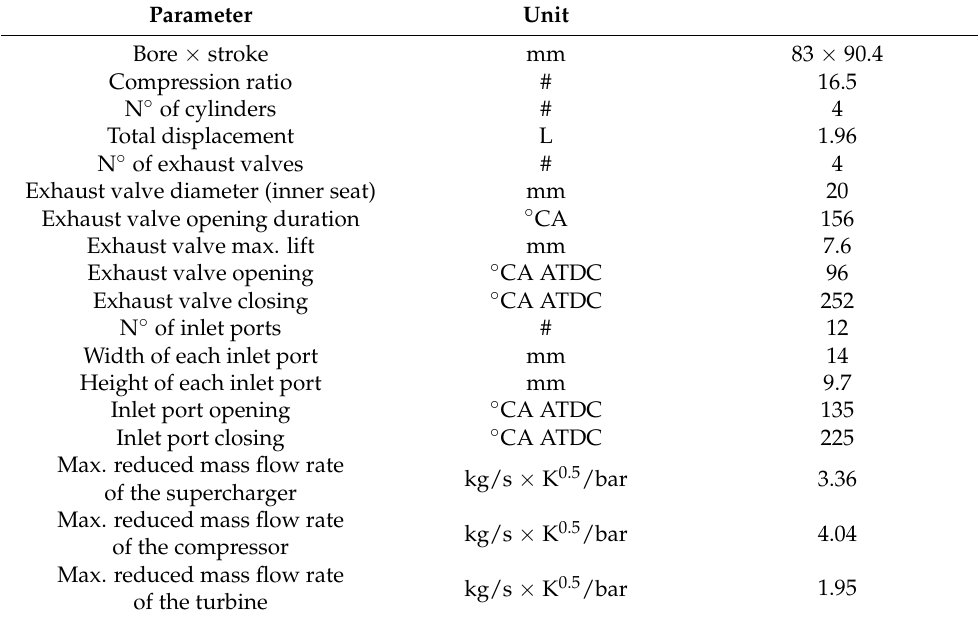
Table 4 reviews the main characteristics of the optimized 2S engine. Table 4. Main characteristics of the optimized 2S